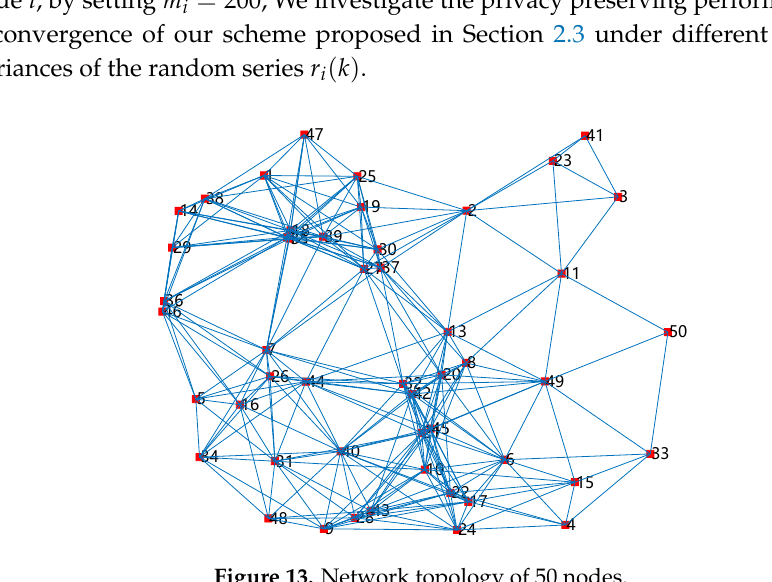
Figure 13. Network topology of 50